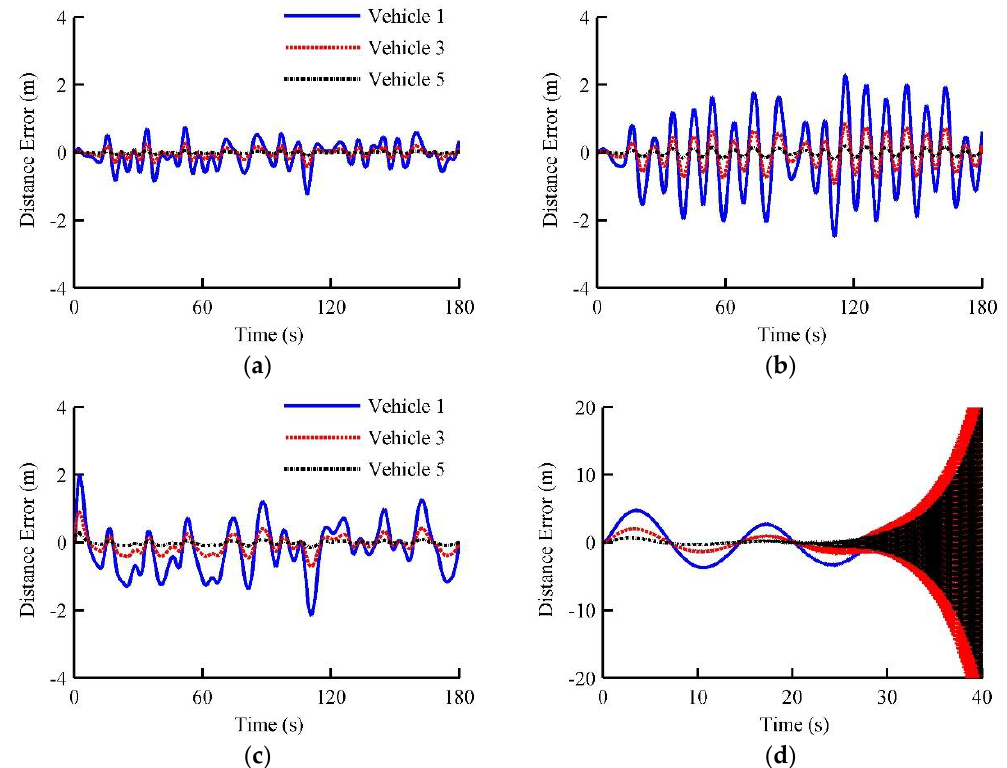
Figure 7. Compared results of different control methods. ( a ) Method 1 (Maximum delay is 0.001 s ). ( b ) Method 2 (Maximum delay is 0.001 s ). ( c ) Method 1 (Maximum delay is 0.08 s ). ( d ) Method 2 (Maximum delay is 0.08 s ).